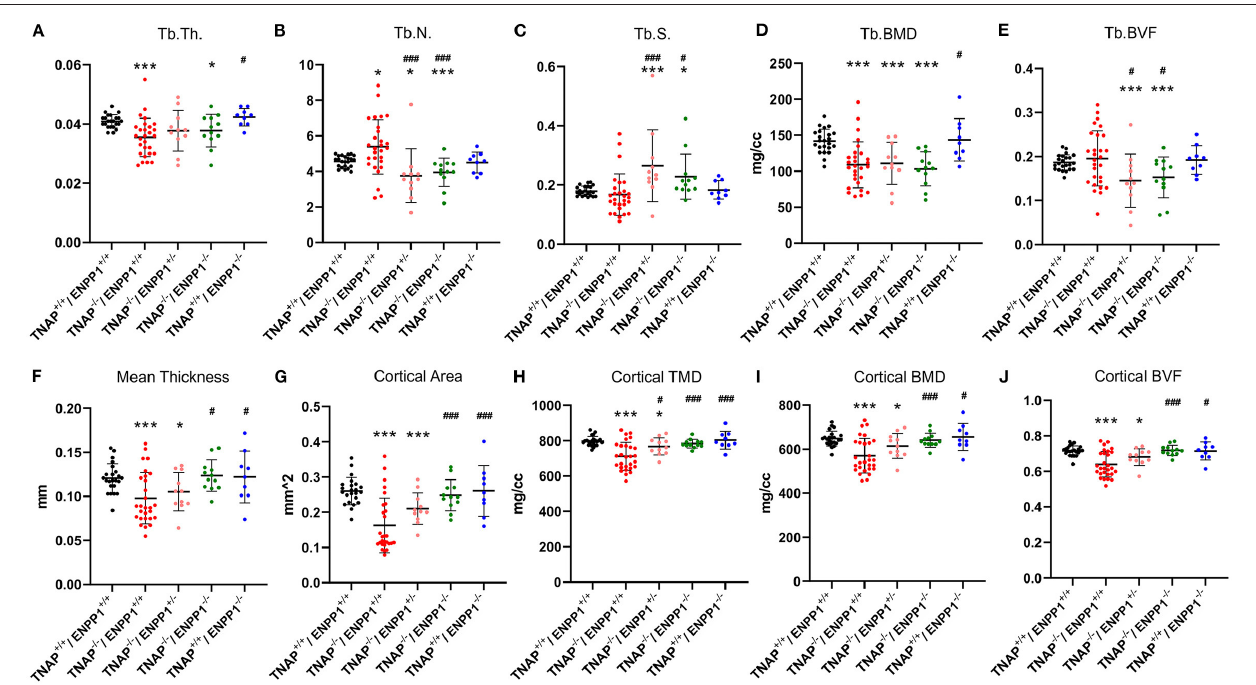
FIGURE 6 | TNAP and ENPP1 ablation effects on long bone. Trabecular thickness (Tb.Th.), number (Tb.N.), spacing (Tb.S.), bone mineral density (BMD) and bone volume fraction (BVF) are shown (A–E) . Cortical mean thickness, area, tissue mineral density (TMD), BMD and BVF are shown (F–J) . TNAP − / − /ENPP1 + / + mice are diminished in trabecular thickness and mineral density with increased trabecular number and no difference in bone volume fraction as compared to TNAP + / + /ENPP1 + / + mice. TNAP − / − /ENPP1 − / − mice are diminished in trabecular thickness, number and bone volume fraction and have increased trabecular spacing compared to TNAP + / + /ENPP1 + / + mice. No differences are seen between TNAP + / + /ENPP1 − / − mice and TNAP + / + /ENPP1 + / + mice. * p < 0.05 vs. TNAP + / + /ENPP1 + / + mice, *** p < 0.005 vs. TNAP + / + /ENPP1 + / + mice, # p < 0.05 vs. TNAP − / − /ENPP1 + / + mice, ### p < 0.005 vs. TNAP − / − /ENPP1 + / +